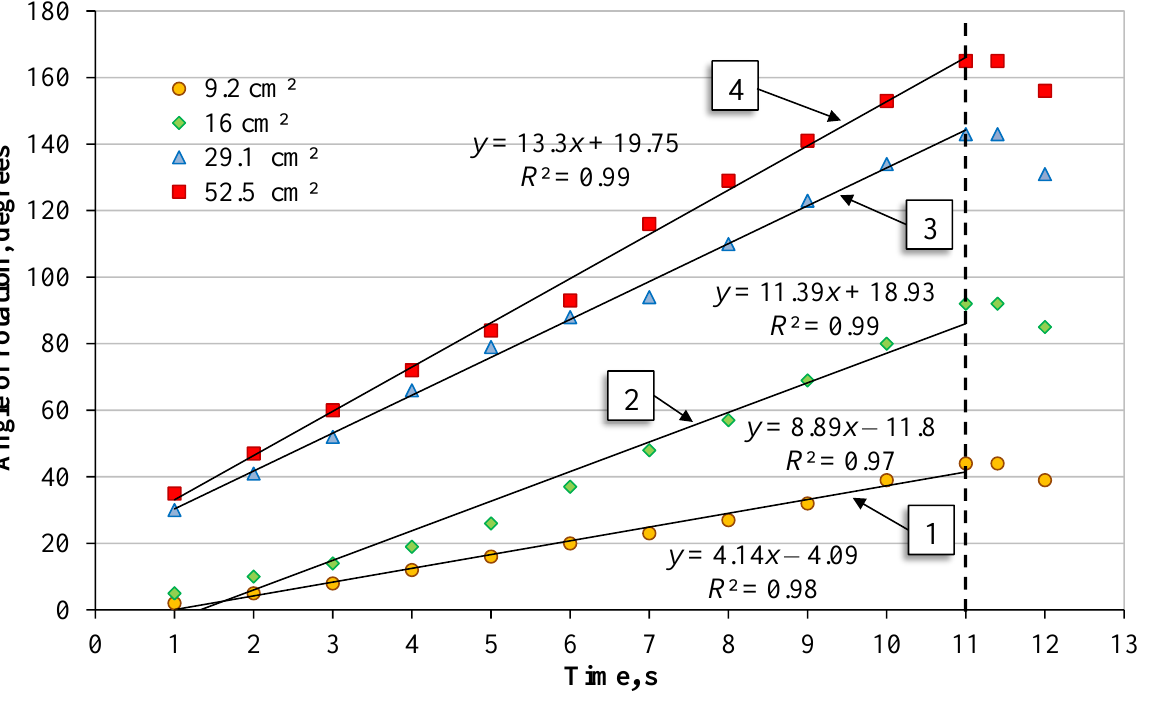
Figure 7. Broad leaved lime ( Tilia platyphyllos Scop ) leaf testing results (heat producing source power is 150 W) ( n = 6): 1—the curve illustrates the angular velocity in degrees of a plant leaf with active blade surface area of 9.2 ± 0.6 cm 2 ; 2—active blade surface area is 16.0 ± 0.8 cm 2 ; 3—active blade surface area is 29.1 ± 1.1 cm 2 ; 4—active blade surface area is 52.5 ± 1.9 cm 2 . The dashed line marks the 11 s limit.